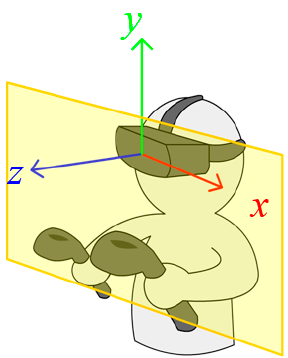
Figure 3. Conceptual image of the virtual screen.